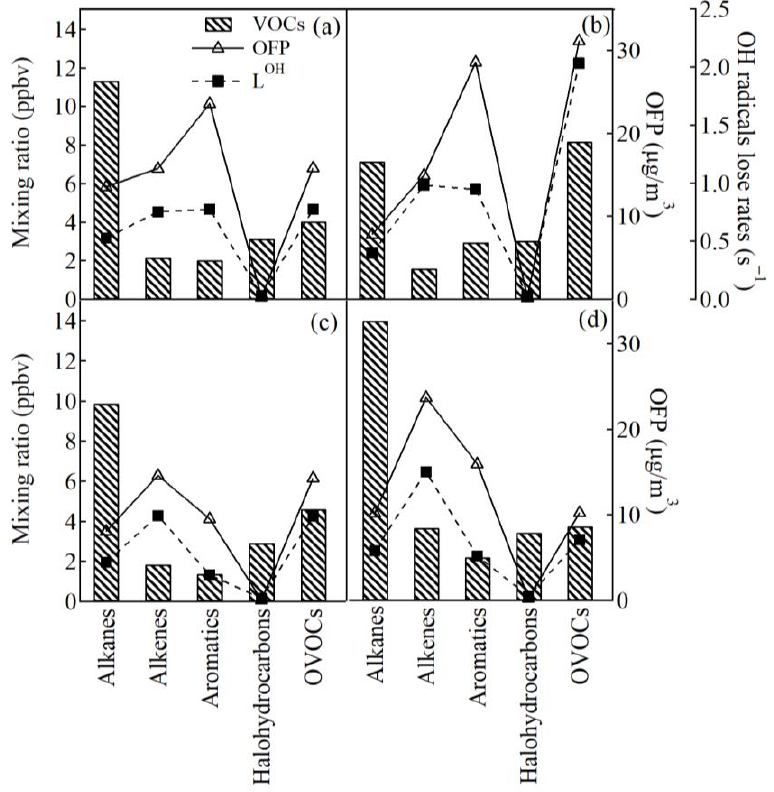
Figure 13. Comparison of five components of VOCs, OFP, L OH in ( a ) spring, ( b ) summer, ( c ) fall, and ( d ) winter.